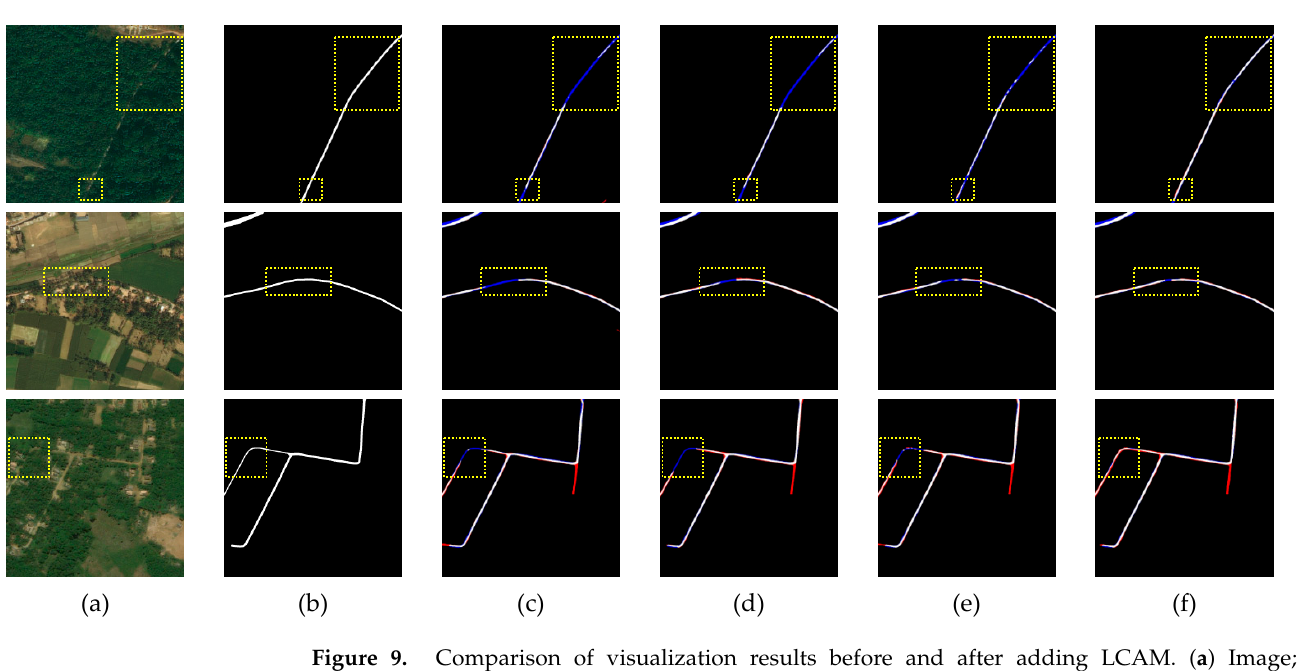
Figure 9. Comparison of visualization results before and after adding LCAM. (a) Image; (b) Label; (c) Baseline results; (d) Baseline + MFEM results; (e) Baseline+MFEM+CAM results; (f) Baseline + MFEM + CAM + SPM results. White: true positive. Black: true negative. Blue: false negative. Red: false positive.